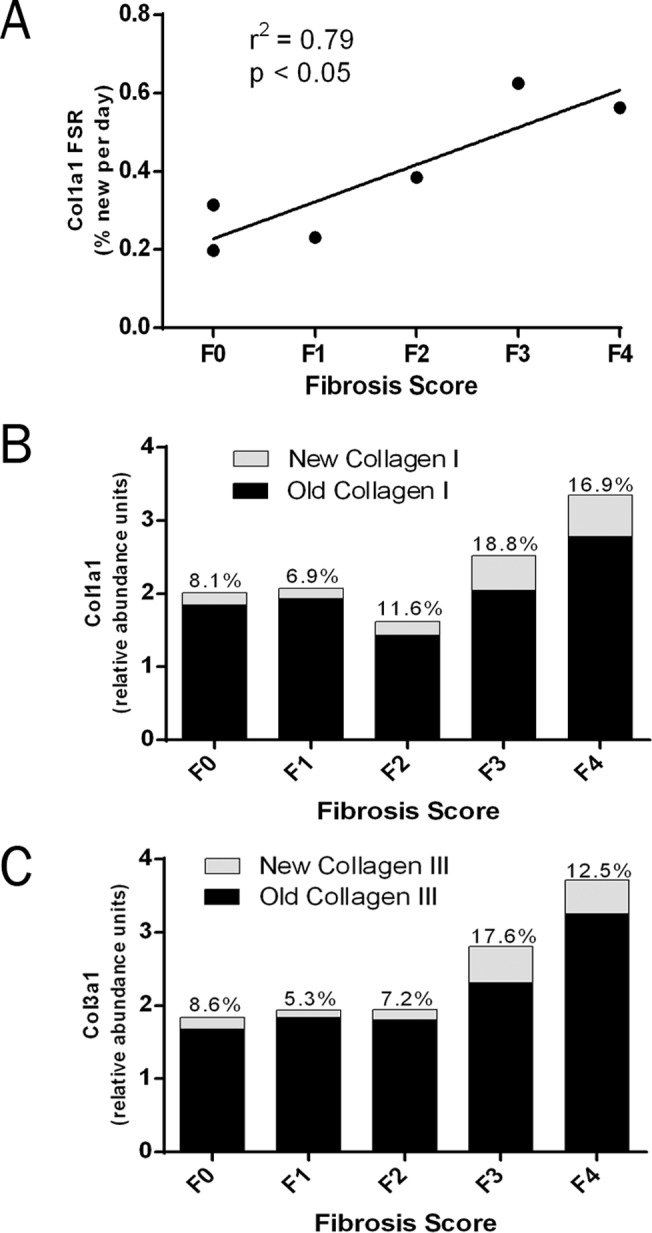
Comparison of Hepatic Collagen Kinetics and Histologic Fibrosis Score.(A) Linear regression of hepatic type I collagen FSR (% new per day) and histopathologic fibrosis score in human subjects with chonic liver disease. (B,C) Bar graphs depicting the relative abundance of unlabeled (old) and labeled (new) hepatic type I collagen (B) and type III collagen (C) per unit mass of liver protein, normalized to 30 days of labeling in vivo. Collagen FSR values (% new per 30 days) are displayed above each bar. Values shown represent the subject or the mean of subjects with each histopathology score. Abbreviation: fractional synthesis rate (FSR).